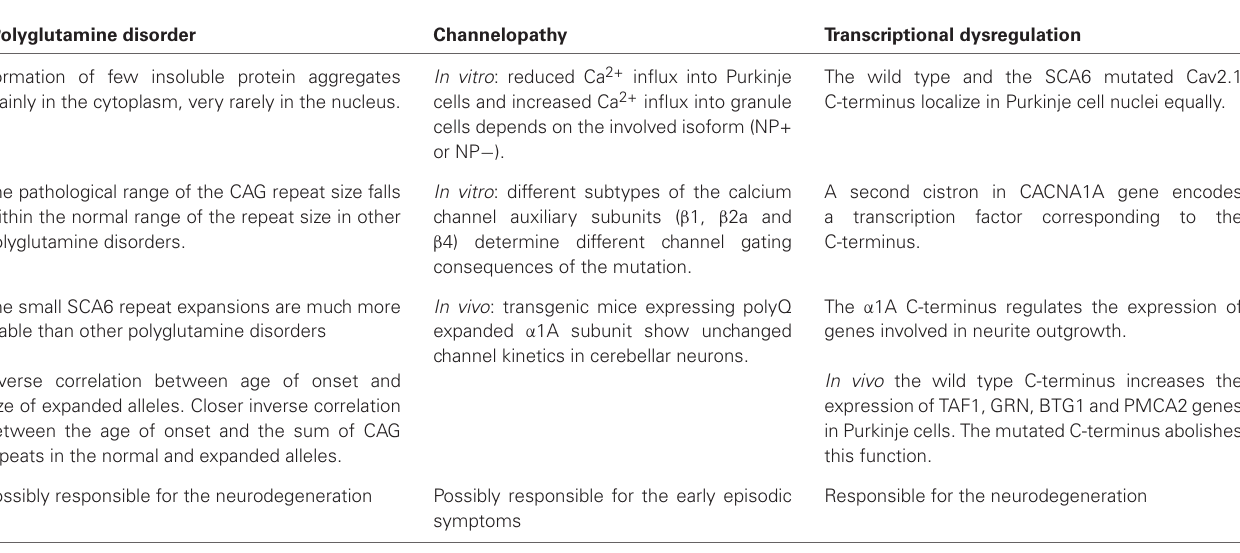
Table 1 | Principal features of the SCA6 molecular mechanism